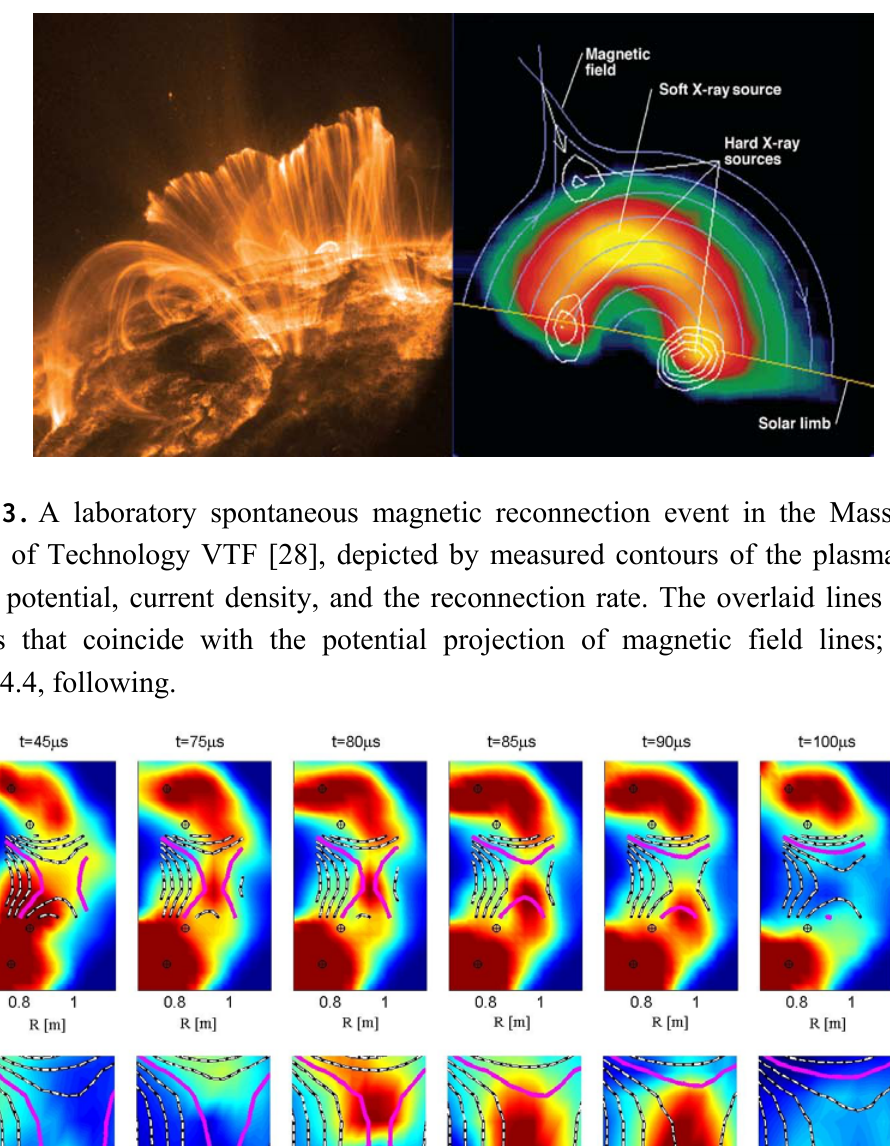
Figure 2. Left: TRACE image (171 Å) of magnetic loops. Right: Yohkoh image of soft X-ray loop and hard X-ray footpoint and loop top emission [25].